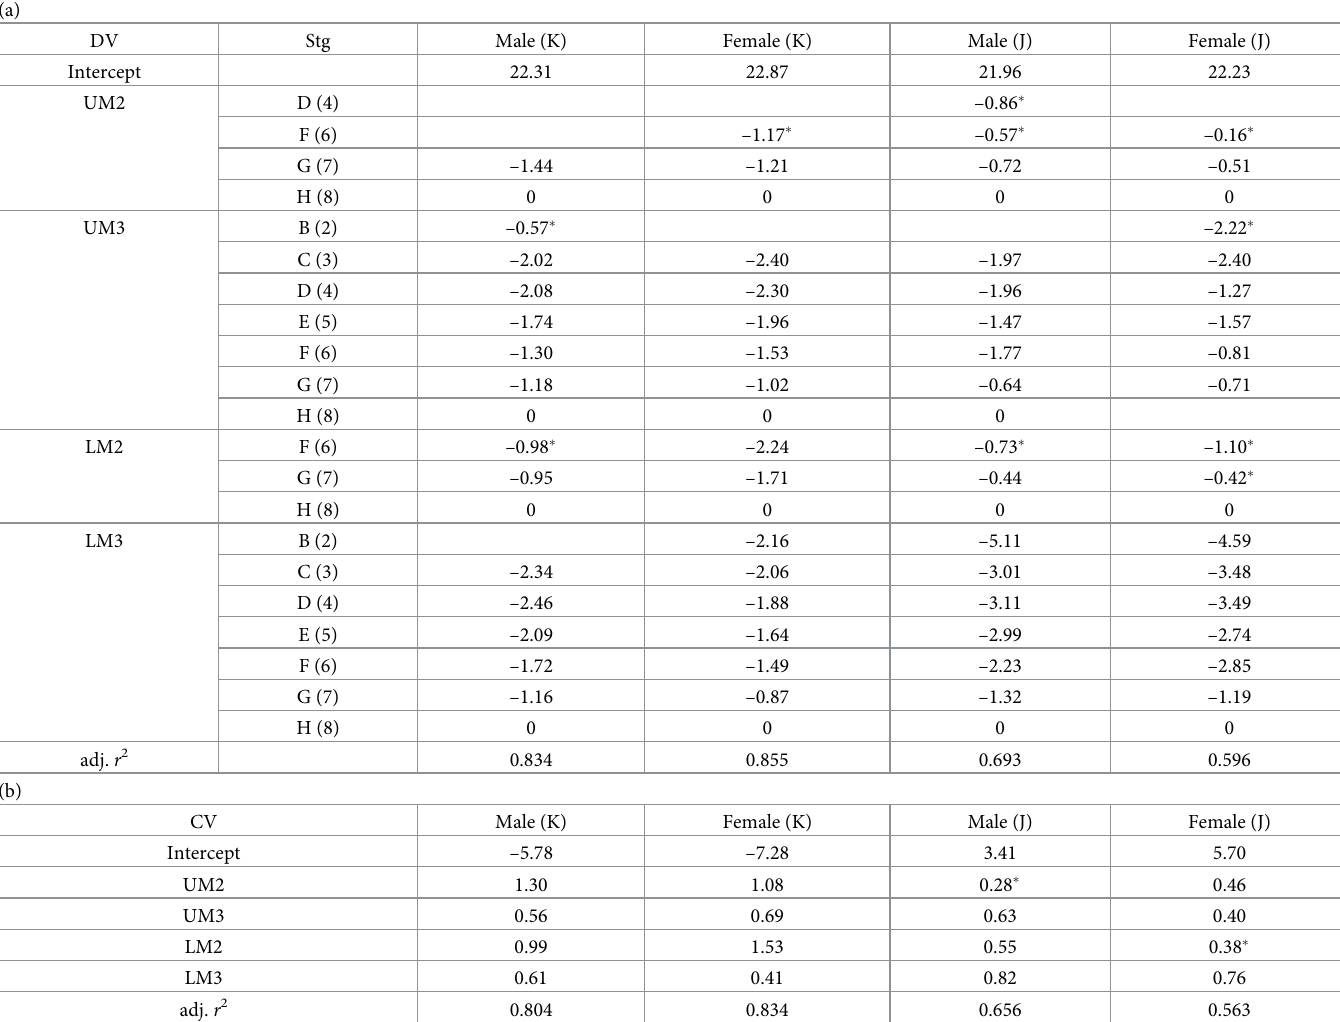
Table 6. Intercepts and coefficients of regression regarding the maturity stages of M2s and M3s as discrete and continuous variables for Korean (K) and Japanese (J) data. (a) DV Stg